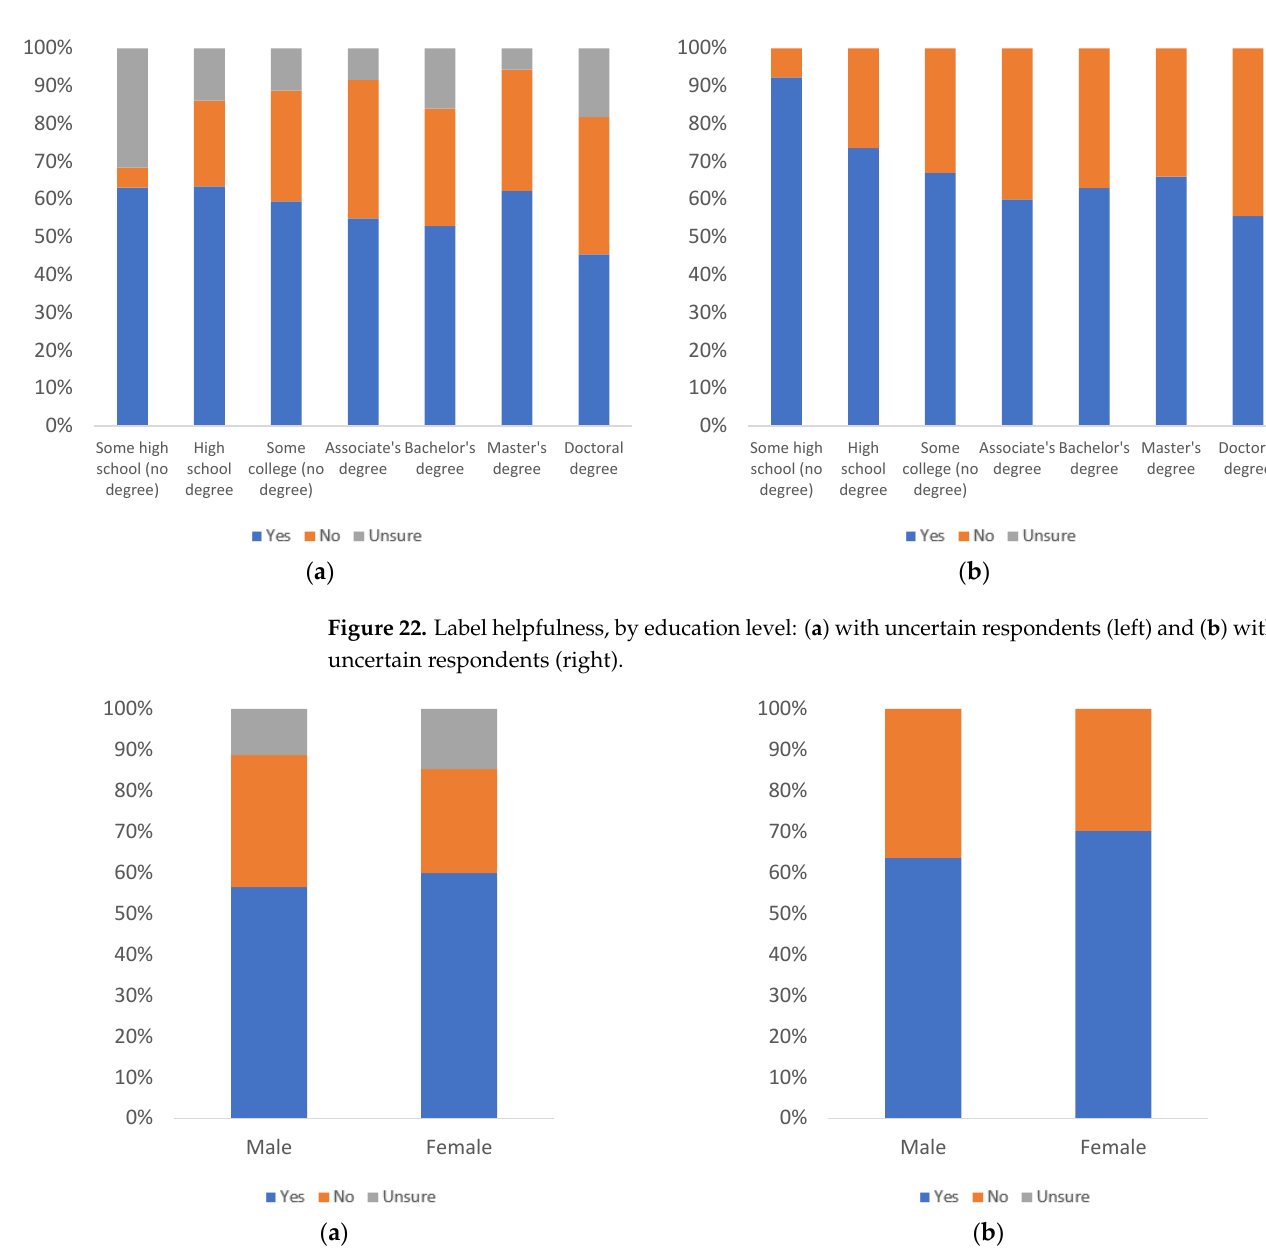
Figure 21. Label helpfulness, by age group: ( a ) with uncertain respondents (left) and ( b ) without uncertain respondents (right).